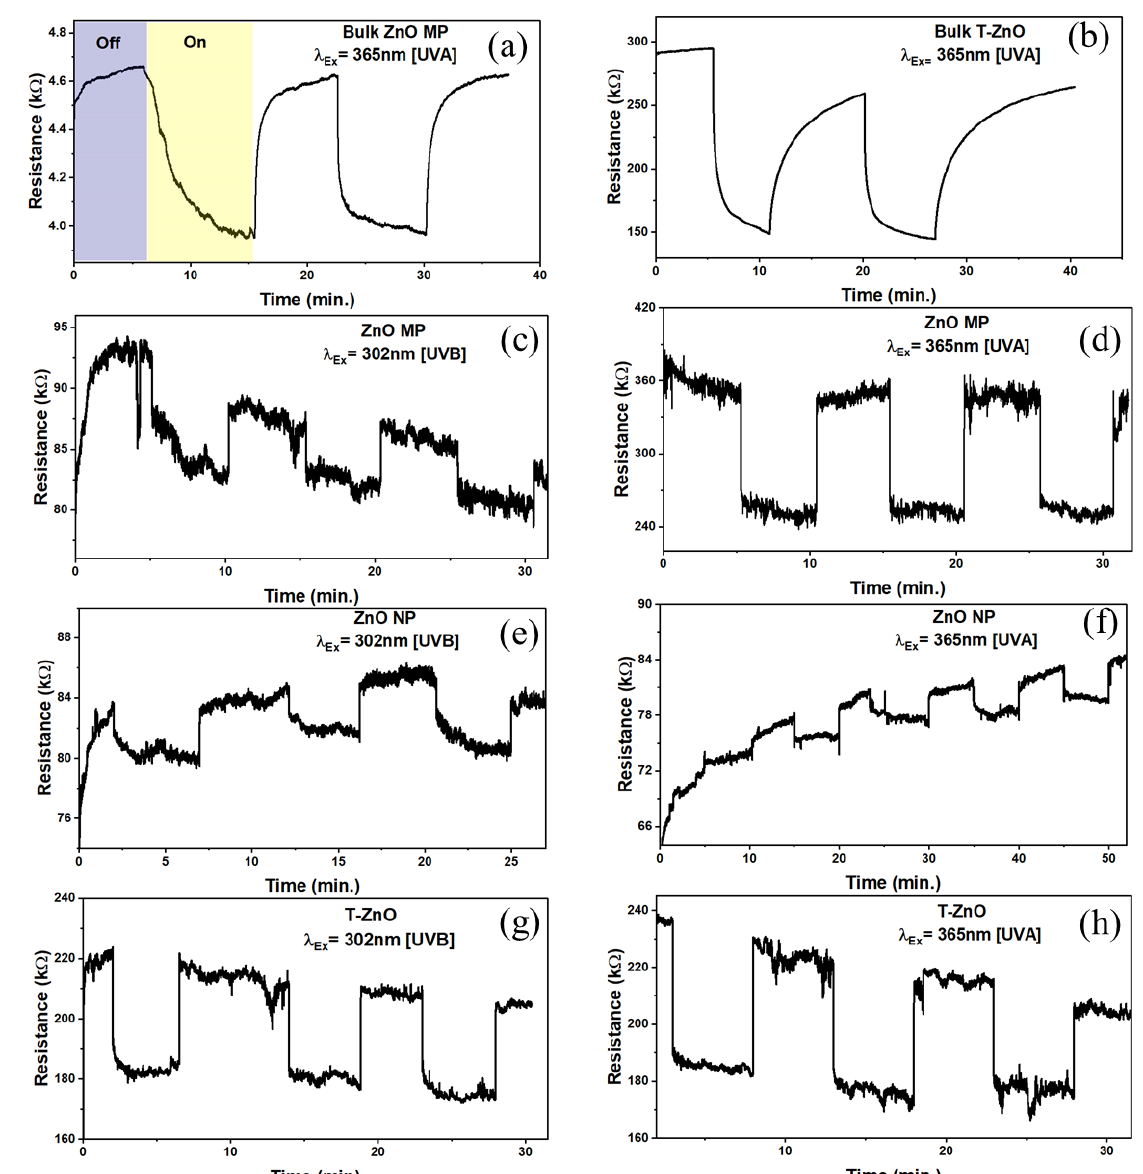
Figure 4. Resistance variation for bulk ( a ) ZnO–MP and ( b ) T–ZnO pellets in ambient environment exposed to UV A (365 nm) monochromatic light. Resistance measurements in enclosed environment exposed to UV A and UV B (302 nm) for ( c , d ) ZnO–MP, ( e , f ) ZnO–NP, and ( g , h ) T – ZnO. Table 1. Summary of sensitivity, response time, and recovery time for various ZnO morphologies and microstructures tested in this study.